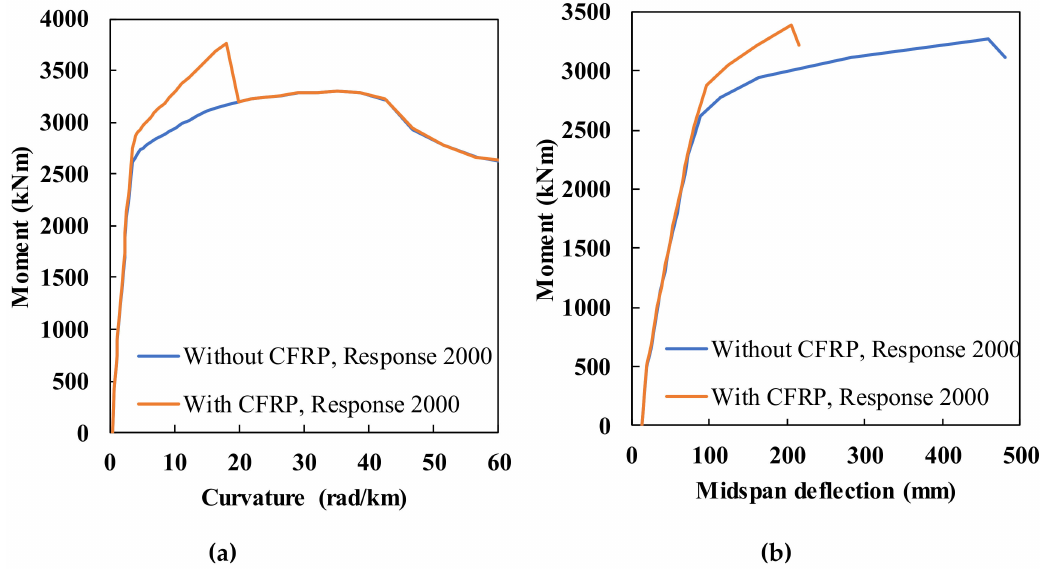
Figure 9. The moment capacity of individual T-beam: ( a ) Section capacity; ( b ) Member